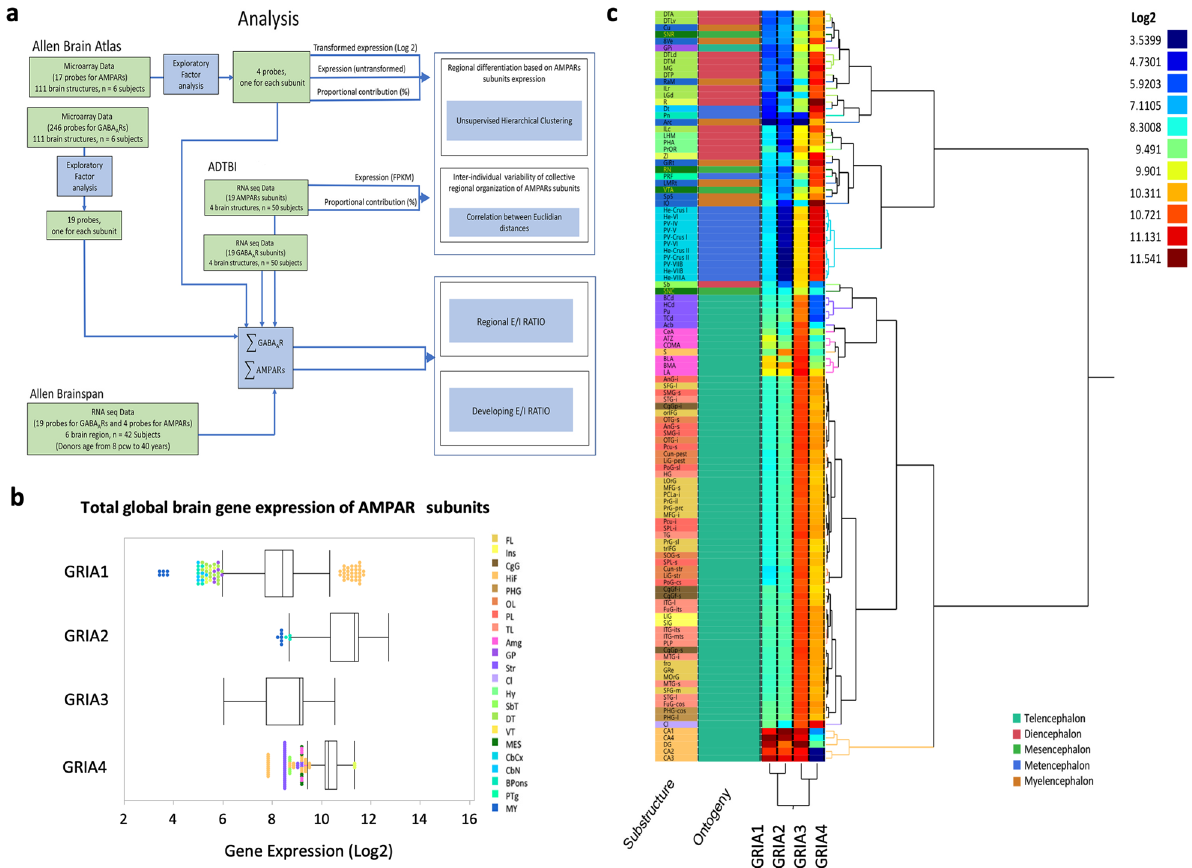
Figure 1. Global and regional transcriptomic analysis of AMPAR subunits (GRIA1-4) in the human brain. ( a ) Diagram detailing transcriptomic workflow. Publicly available data from the Allen Brain Atlas, Brainspan, and the ADTBI studies were filtered using exploratory factor analysis and analyzed at the global and regional levels for both GRIA1-4 expression and t E/I ratio patterns. ( b ) Box plots of microarray gene expression from the